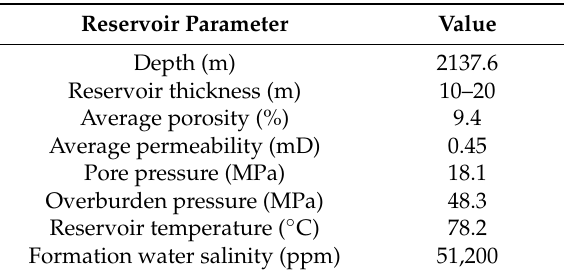
Table 1. Basic parameters of the Huang 3